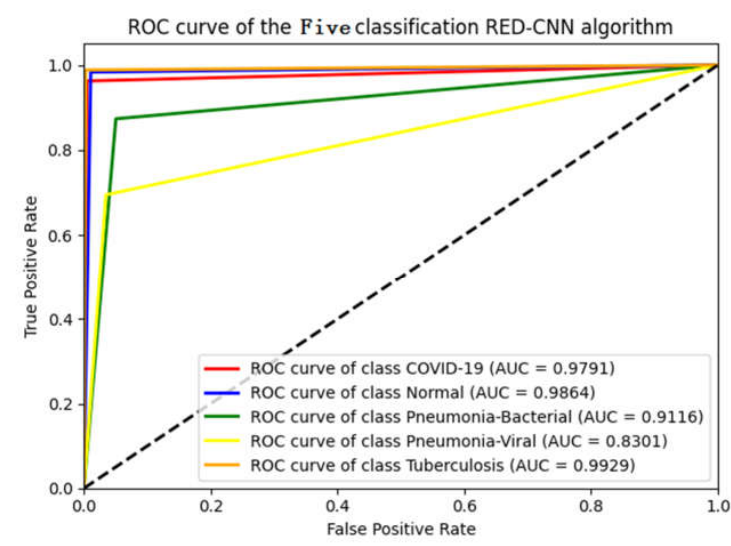
Figure 10. Five-category average value of AUC curve. Table 5. Comparison of RED-CNN with other studies based on tuberculosis (TB) chest X-ray database.